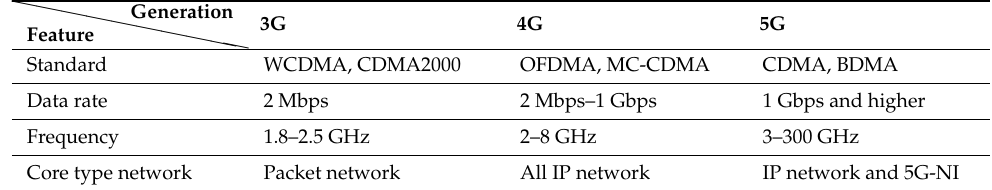
Table 6. Important Features in 3G, 4G, and